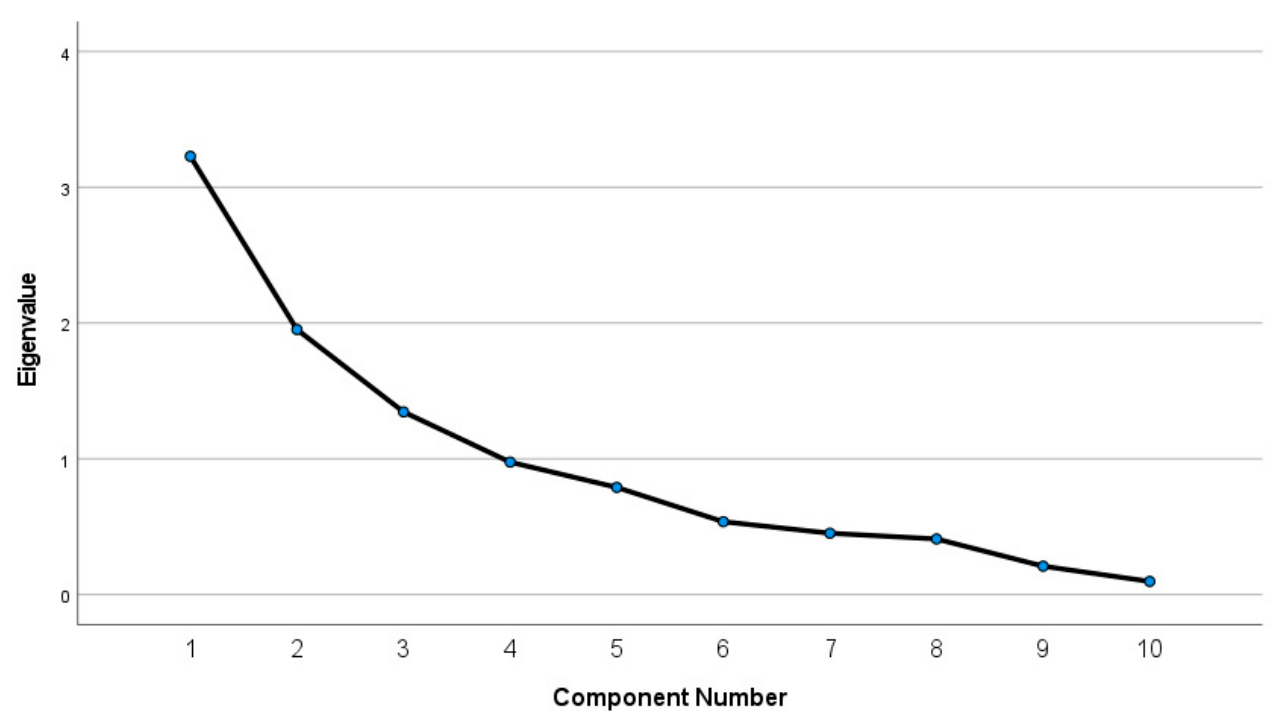
Table 10. Pattern matrix acquired in the principal component analysis regarding benefits of implementing Industry 4.0